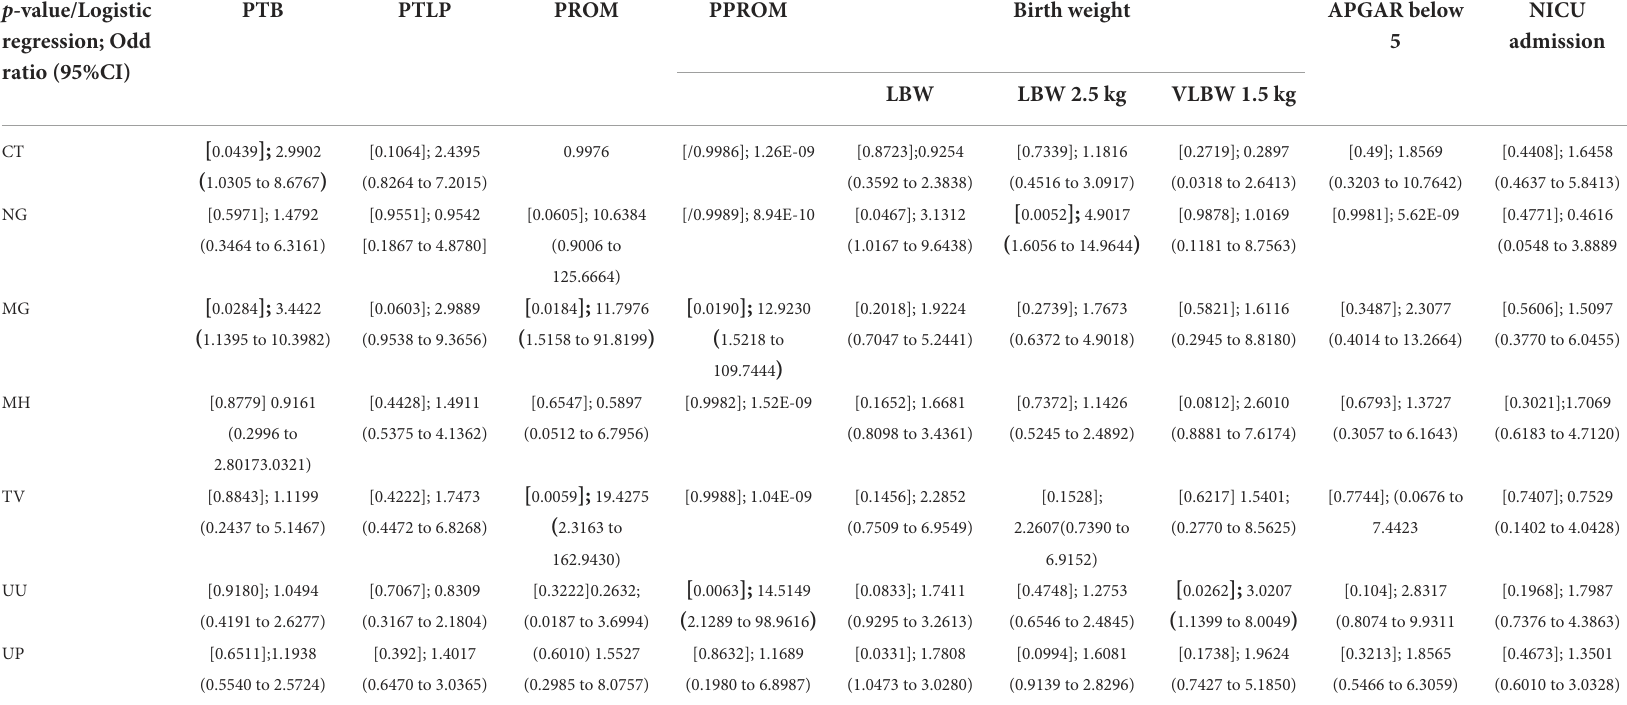
TABLE 3 Statistical association between type of infection and adverse